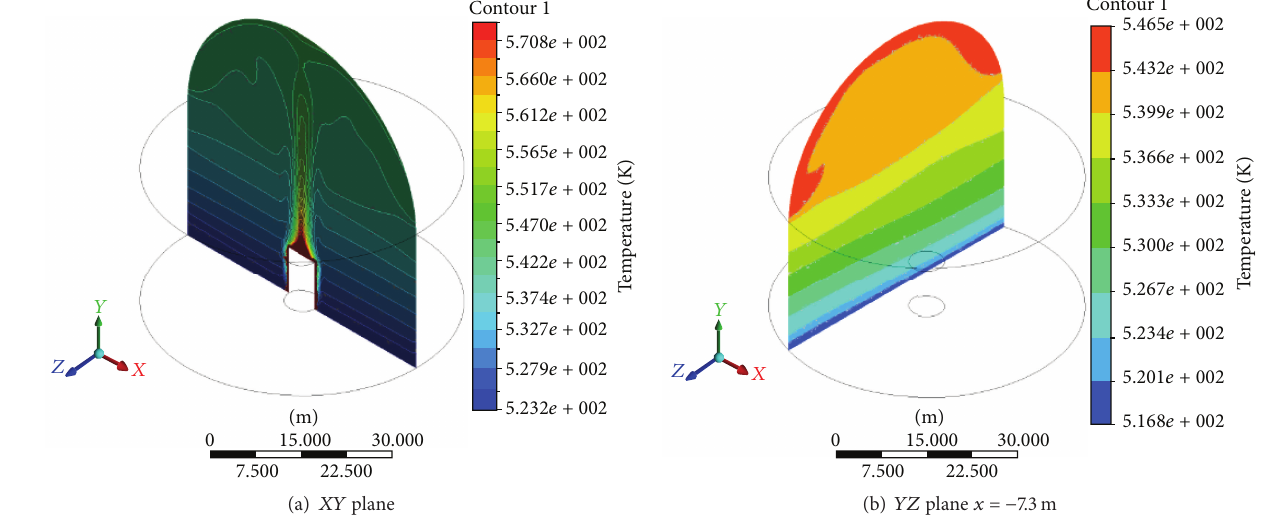
Figure 5: Contour plot of the temperature at 10106 s.